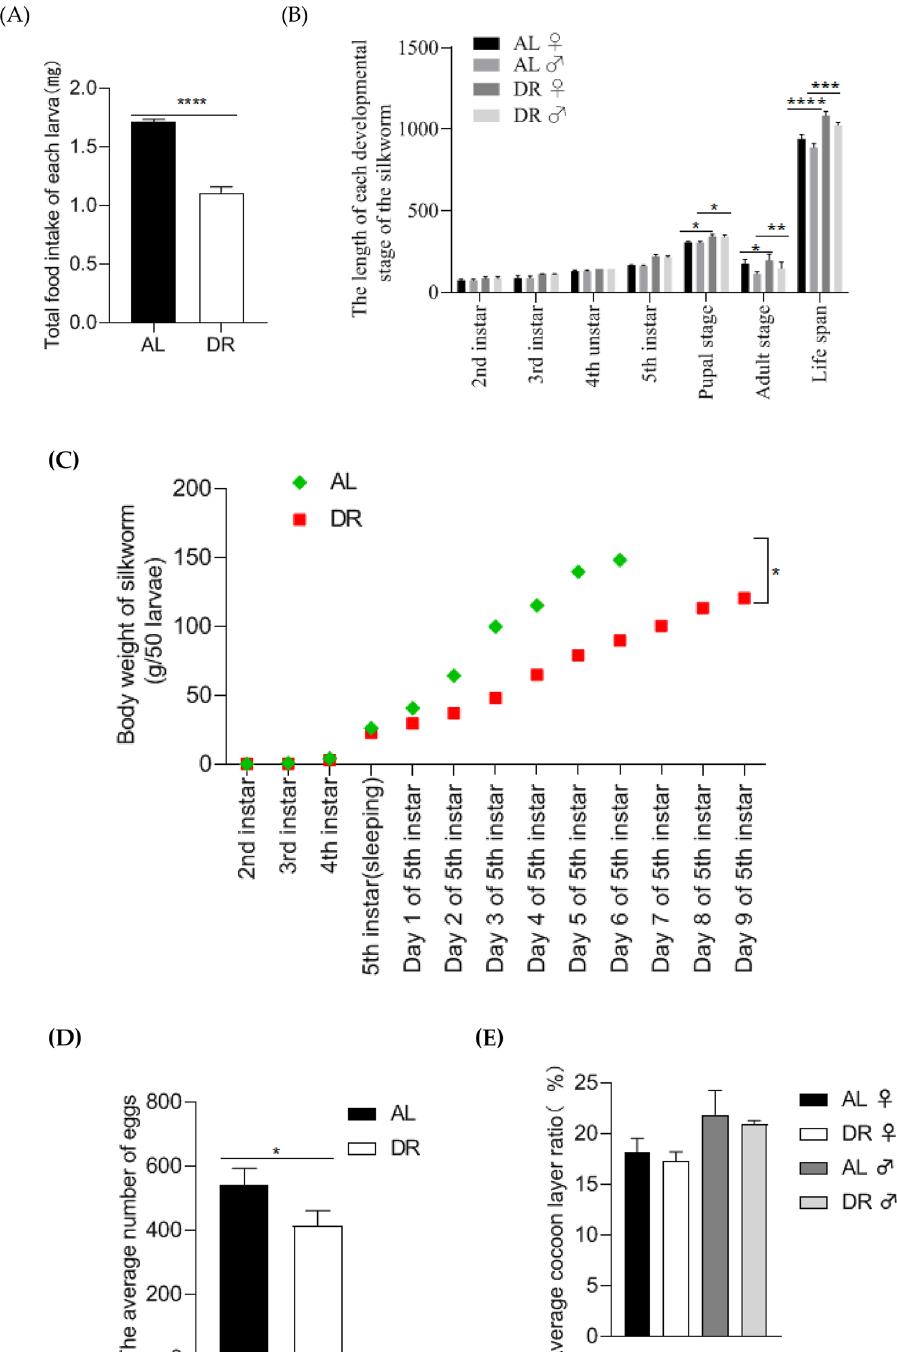
Figure 1. Effects of DR on the Life Index of Silkworms. ( A ) The feeding amount in DR and AL group; ( B ) Comparison of the duration of each instar of Bombyx mori in DR and AL group; ( C ) Body weight of silkworm larvae at different stages,the chart shows the weight per 50 larvea; ( D ) Comparison of the number of eggs laid by females in DR and AL group; ( E ) Comparison of cocoon layer rate between DR and AL